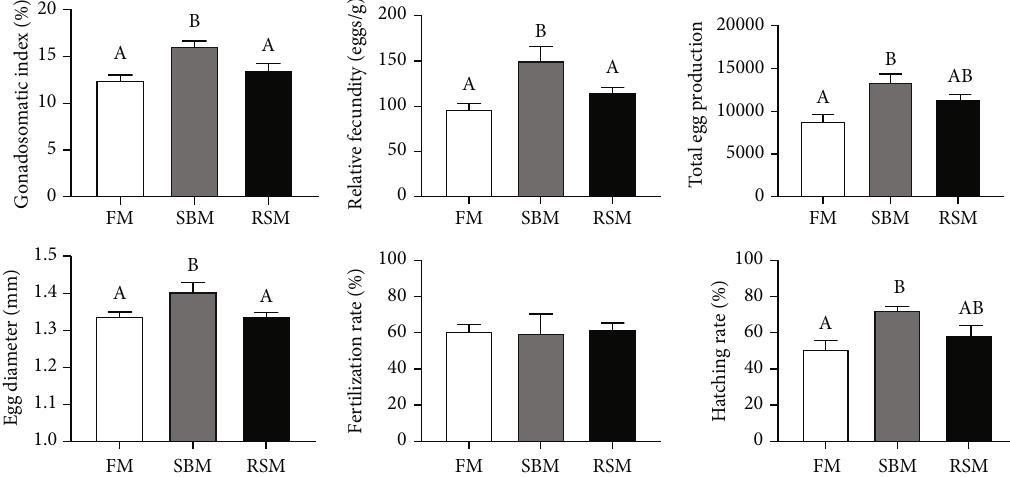
Figure 1: E ff ects of di ff erent protein sources on reproductive performance of female yellow cat fi sh broodstock. GSI: gonadosomatic index ð % Þ = 100 × ð ovary weight Þ / ð body weight Þ ; relative fecundity = total egg total egg production per female/meanweightof female ; fertilization rate ð % Þ = 100 × ð number of fertilizedeggs/totalnumber of eggs Þ ; hatchingrate ð % Þ = 100 × ð number of hatched fries/numberof fertilized eggs Þ . Values are expressed as means ± SE ; di ff erent letters represent the statistically signi fi cant di ff erences ( P < 0 : 05 ).